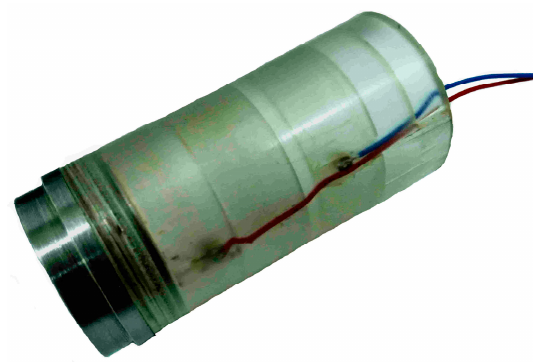
Figure15. Images of the MCP with D = 20 mm and L = 50 mm. Figure 15. Images of the MCP with D = 20 mm and L = 50